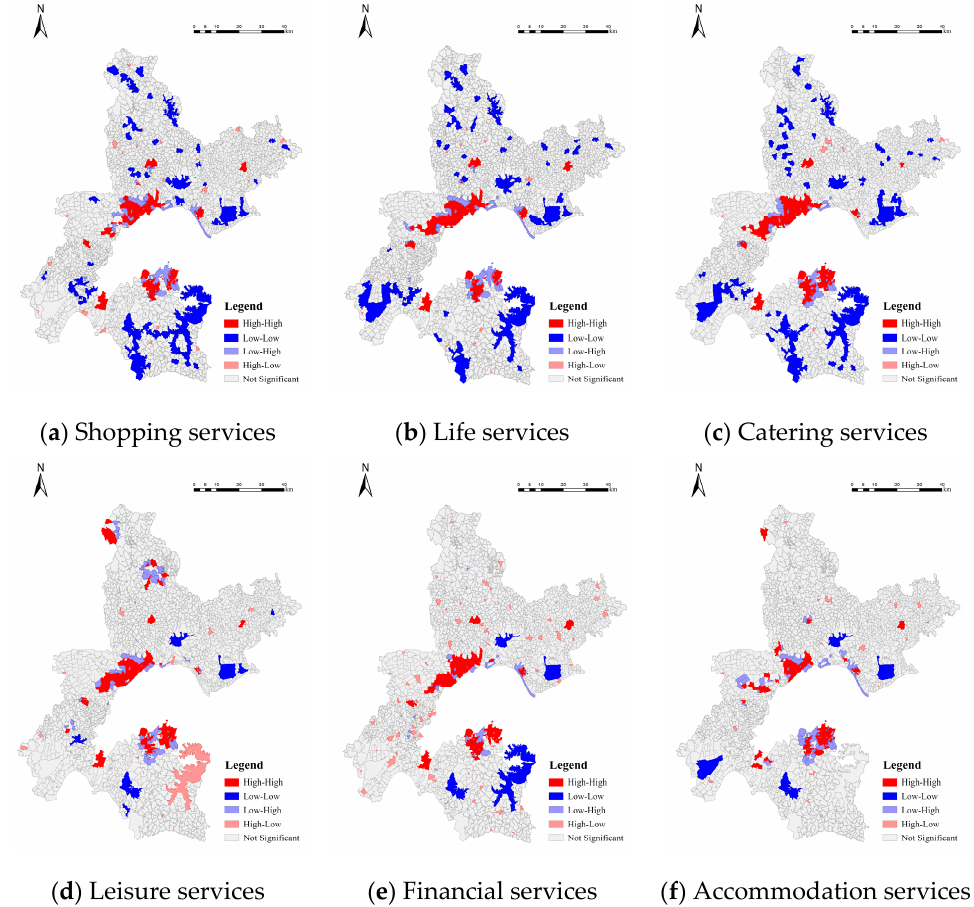
Figure 7. LISA map of different types of market services industries in Wuhan city’s new urban